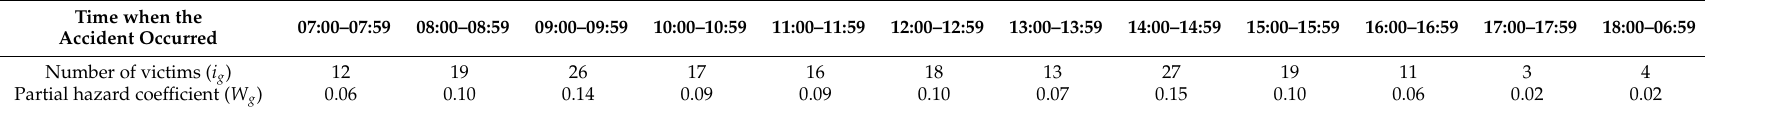
Table 4. Time of